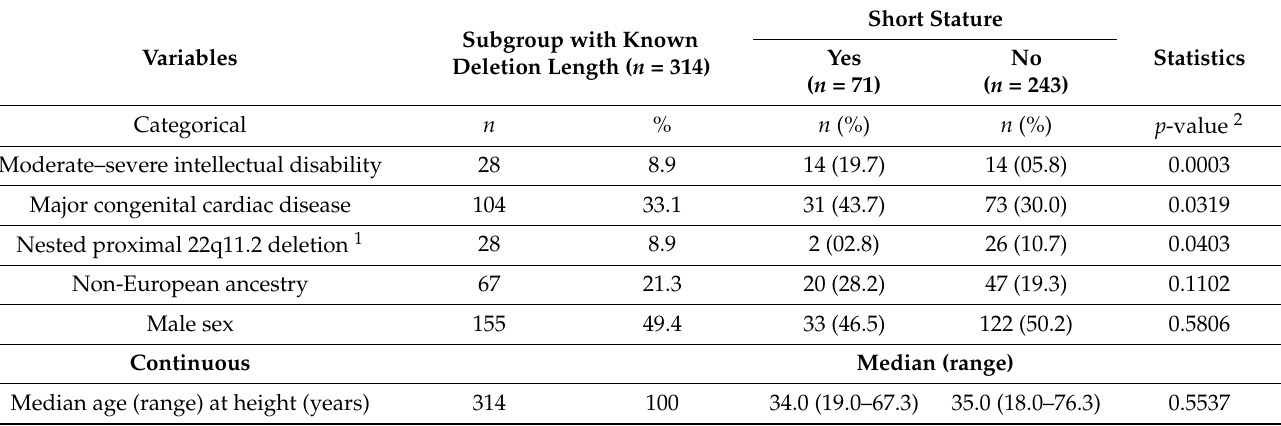
Table 1. Clinical and demographic factors for adults with 22q11.2 deletion syndrome for the sub ‐ group of n = 314 with known 22q11.2 deletion length.